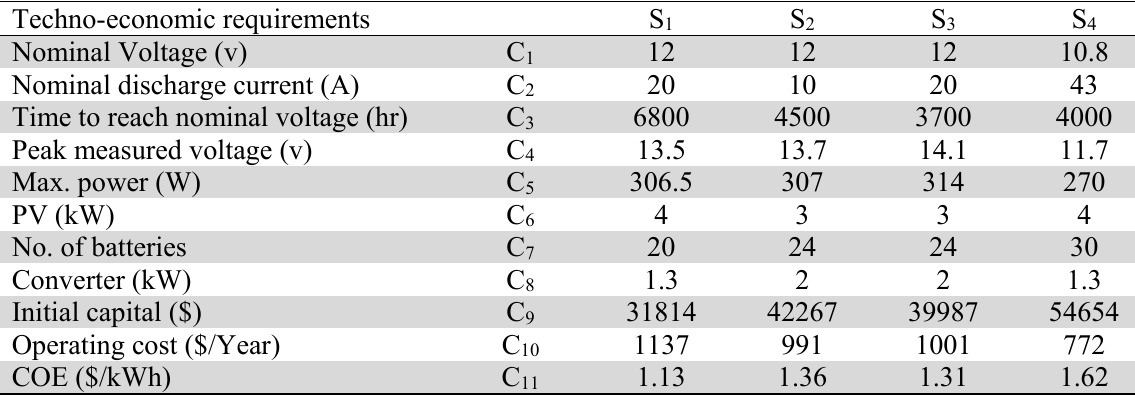
Techno-economic data for EST (Garimella & Nair, 2009)